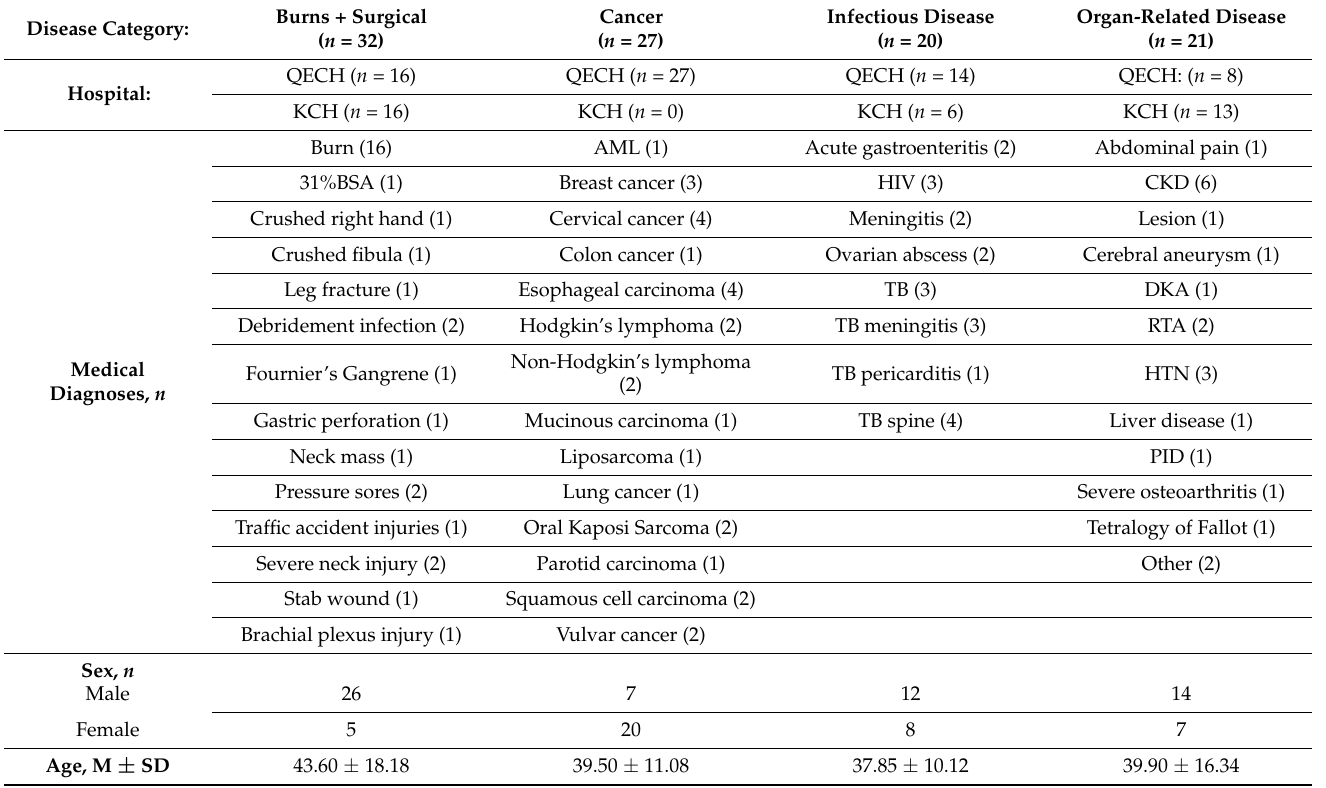
Table 2. Disease categories by medical